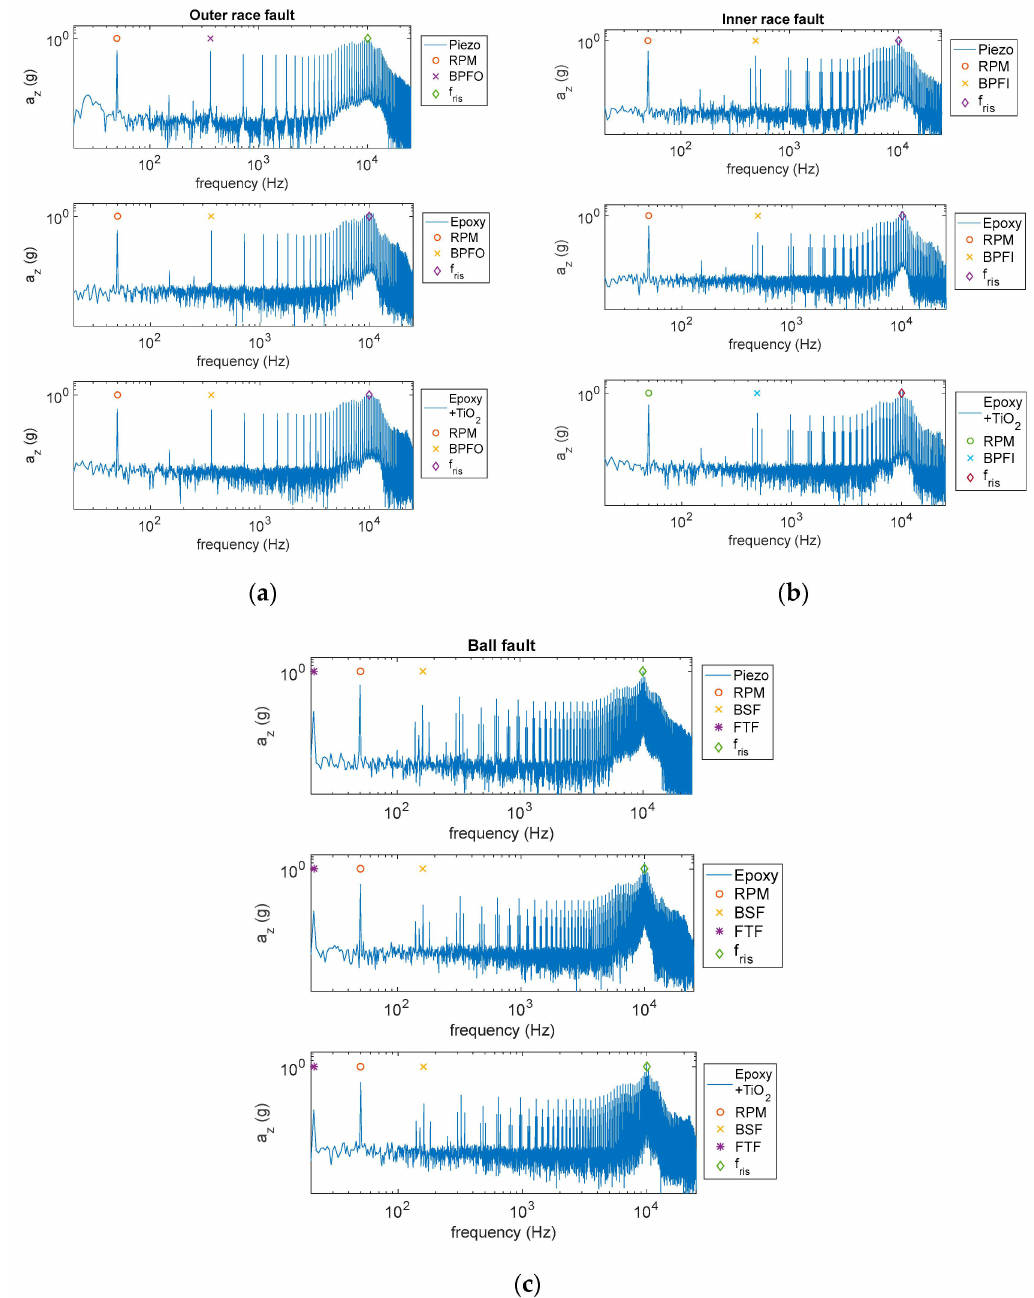
Figure 16. Measured fault signature vibration signals spectra. Sampling frequency = 160 kHz. ( a ) Outer race fault; ( b ) inner race fault; and ( c ) ball fault. Upper plots—signals measured by the reference piezoelectric accelerometer; middle plots—signals measured by the proposed MDUT encapsulated in epoxy resin; and lower plots—signals measured by the proposed MDUT encapsulated in epoxy resin reinforced with TiO 2